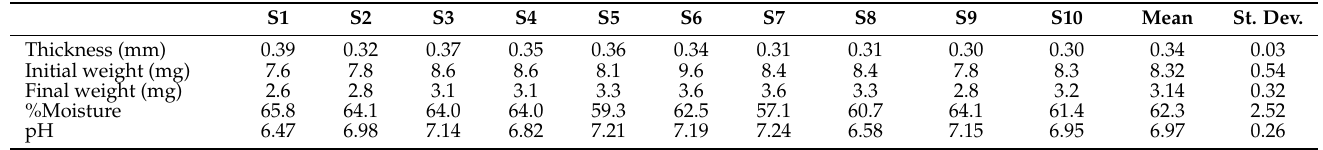
Table 1. Determination of thickness, weight uniformity, and percent moisture